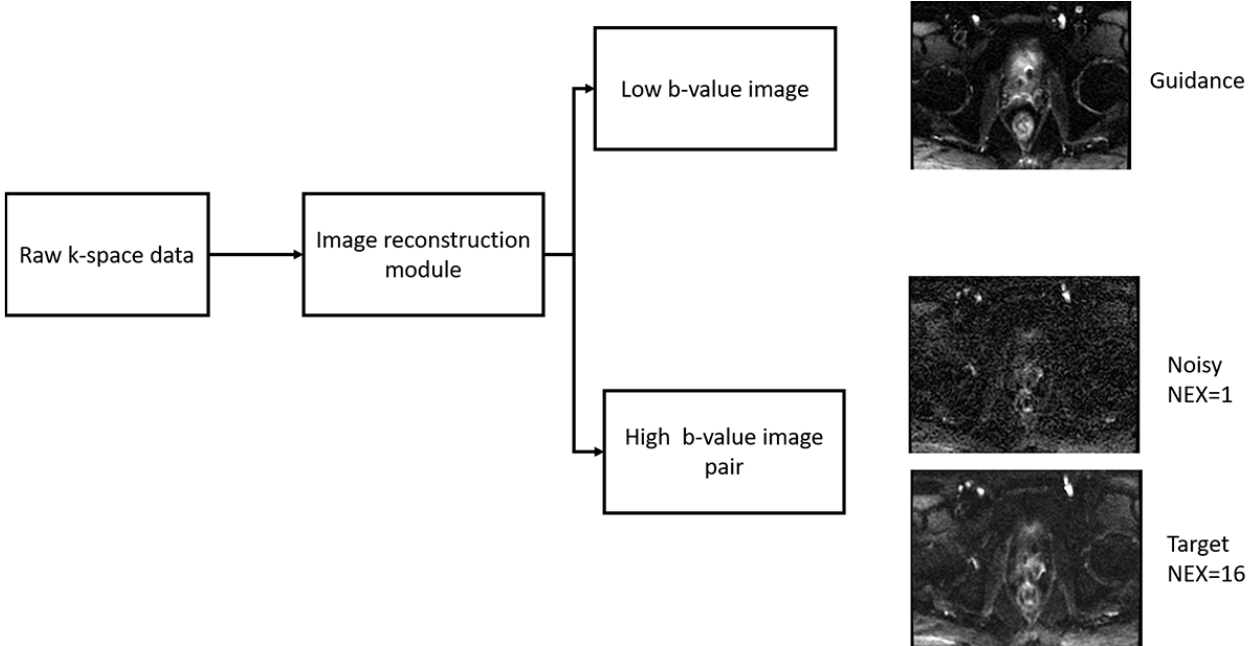
Figure 1. Offline reconstruction of DWI raw data. Raw k-space data from every patient was recon- structed to produce three images: guidance (low b -value DWI), noisy (high b -value DWI reconstructed with NEX = 1, 2, and 4), and reference (high b -value DWI reconstructed with NEX = 16).